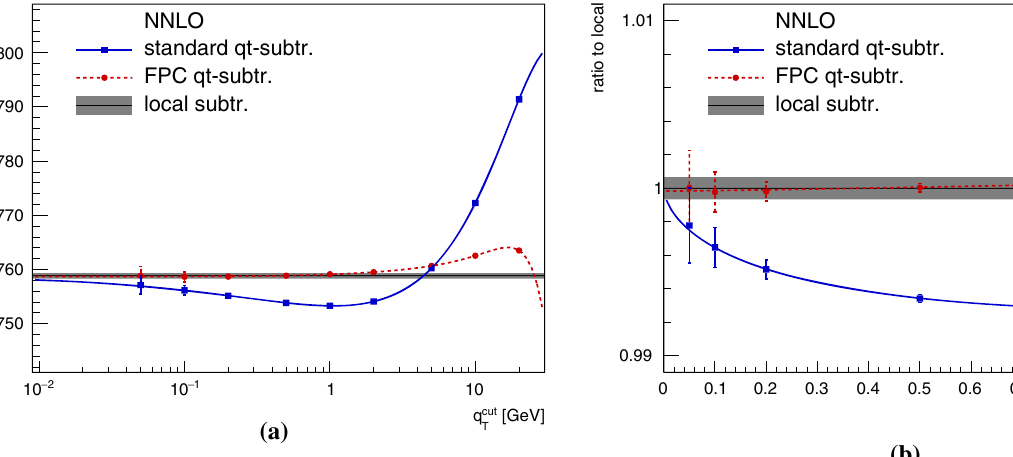
Fig. 2 Fiducial cross section for the production of l + l − pairs from √ Z /γ ∗ decay at the LHC ( s = 13 TeV). NLO results with the q T subtraction method (blue squared points) and the q T subtraction with-